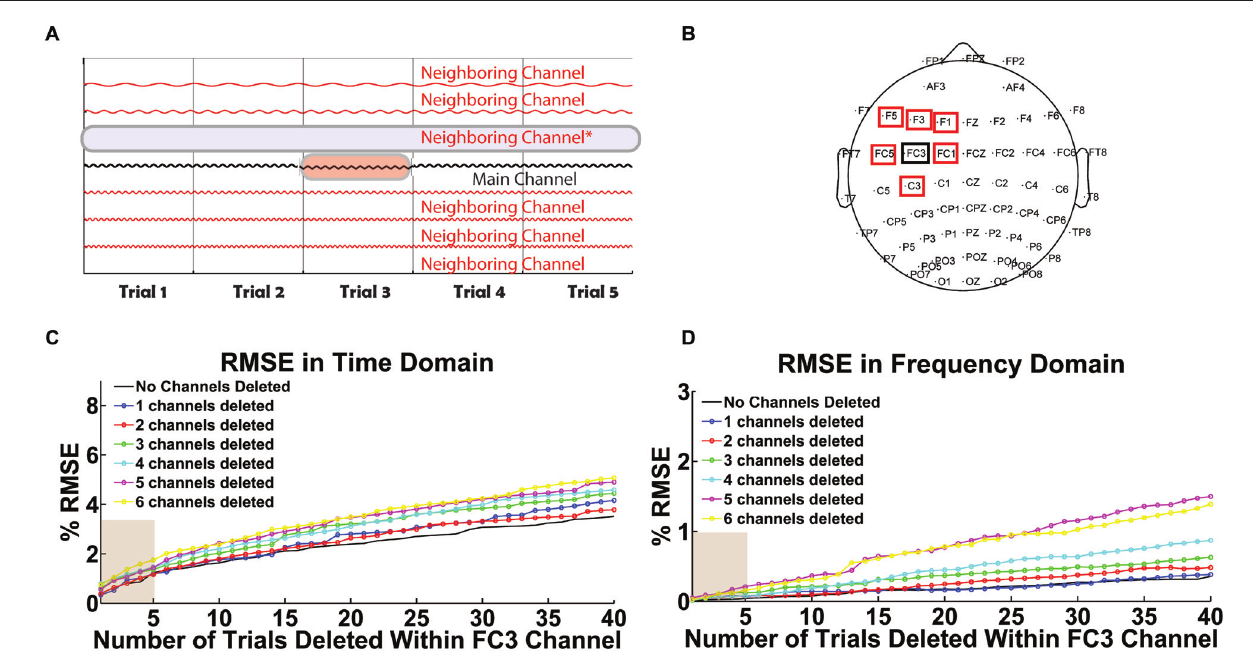
FIGURE 10 | User-defined threshold for selective interpolation. (A) The schematic illustrates the data array modification when a user tags a trial within a channel (highlighted in red) or a full channel (highlighted in blue) for removal in Steps 3 or 9. Tagged trials within a channel are interpolated while tagged channels are deleted. (B) The scalp map highlights the main channel selected for interpolation (FC3 in black) and its neighboring channels that could be deleted. In (C,D) , x -axes represent the total number of trials interpolated within channel FC3 and y -axes represent the corresponding percent root mean square error (% RMSE). Legend is used to illustrate the total number of deleted neighboring channels. These two plots depict the error in data interpolation in the (C) time domain and (D) frequency domain. They illustrate a linear increase in interpolation error when an increasing number of trials are interpolated within FC3. Interpolation error also increases with the cumulative deletion of neighboring